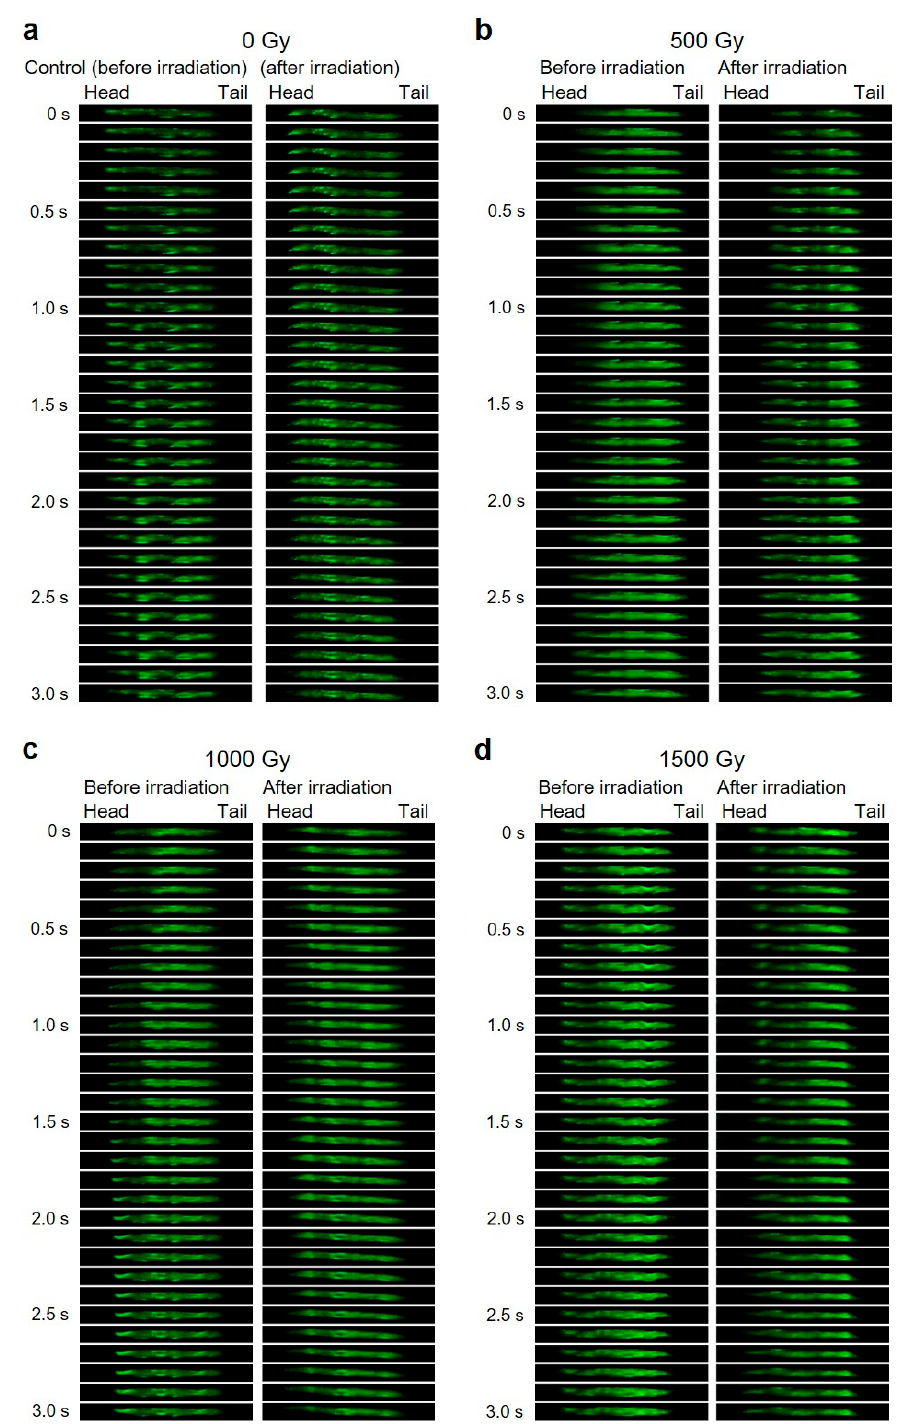
Figure 1. Schematic of the CNS-targeted irradiation of individual live C. elegans using a microfluidic chip. ( a ) Cross-sectional view of CNS-targeted irradiation of a live C. elegans enclosed in a microfluidic channel of a microfluidic chip. Anatomical structure of an individual C. elegans in the right panel was compiled with reference to a previous report [3]. ( b ) Schematic of a 300-µm, ultra-thin, ion-penetrable, wettable, microfluidic chip (Worm Sheet IR) enclosing live C. elegans individuals in the microfluidic channels. ( c ) Overhead view of the anterior body of an individual live C. elegans enclosed in a straight microfluidic channel of a microfluidic chip. The whole nerve ring in a ∅ ⌀ 60-µm micro-aperture region (filled in blue) or the center of the nerve ring (CNS) in a ⌀ 20-µm micro-aperture region (filled in yellow) were targeted and irradiated with an exact number of carbon ions.